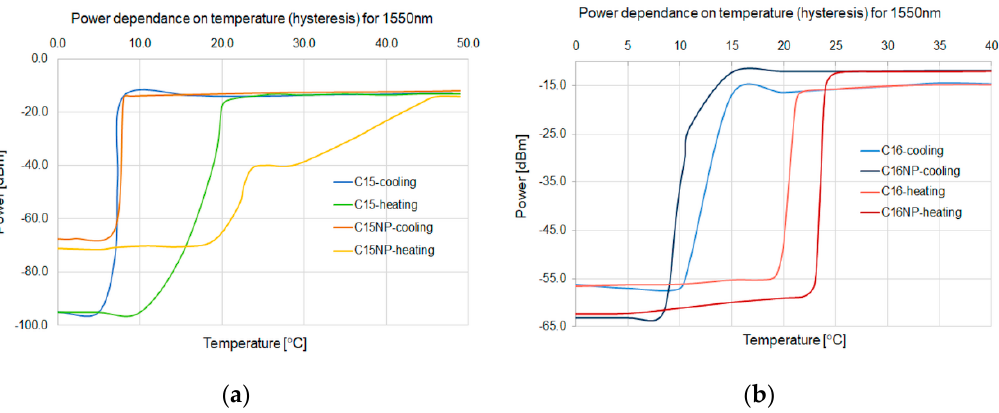
Figure 8. Temperature hysteresis of C15 ( a ) and C16 ( b ) for pure materials and with nanoparticle changes for a 1550 nm light beam.